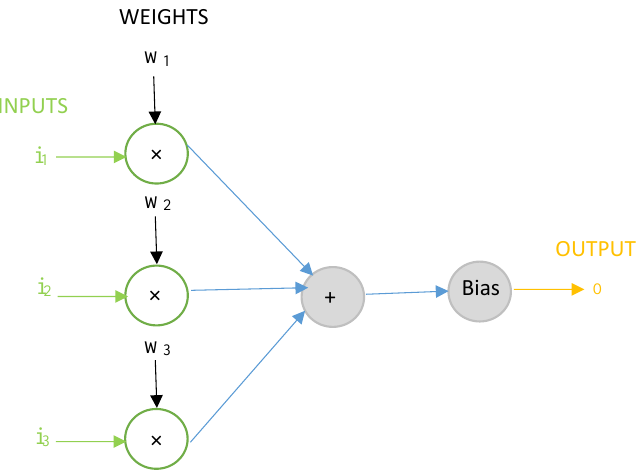
Figure 1. A computational neuron in the artificial neural network (ANN) model. A feedforward network is an ANN with a forward flow of information from an input layer to an output layer through one or more computational layers known as hidden layers. Figure 2 shows the system model of a multilayer feedforward neural network. The input layer comprises nodes that represent the input parameters or features in the data fed into a network model. The hidden layer has numerous neurons that operate on the weighted inputs using an activation function. The output layer comprises one or more output nodes that utilize an activation function to give the estimated output y . The neurons in consecutive layers are connected. The term multilayer signifies the number of layers with an activation function. A feedforward network is said to be a single-layer network if its input layer is directly connected to the output layer. A feedforward network is said to be a two- or three-layer network if its input layer is connected to the output layer through one or two hidden layers, respectively. The input features in data are represented by i 1 , i 2 , . . . , i n where n is the number of input features. Hidden layers are represented by h 1 , h 2 , . . . , h l where l is the number of hidden layers. Each hidden layer can have multiple neurons as their elementary unit, as represented by shaded circles. The output layer is represented by a single functional unit that estimates the actual output or target t in experimental